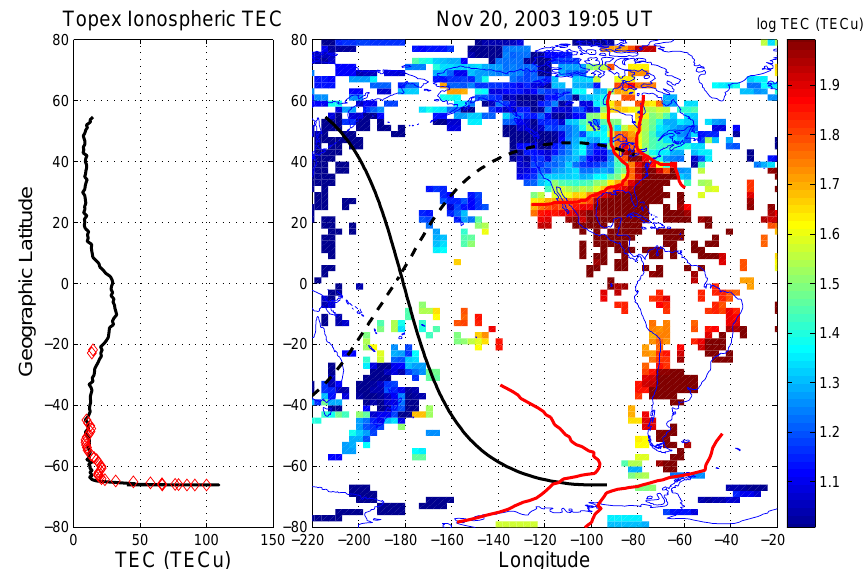
Fig. 4. SED streaming into the polar caps created magnetically-conjugate TOI during the 30 November 2003 event. Topex intersected the southern TOI in the region magnetically conjugate to the GPS TEC SED/TOI observed in the north.